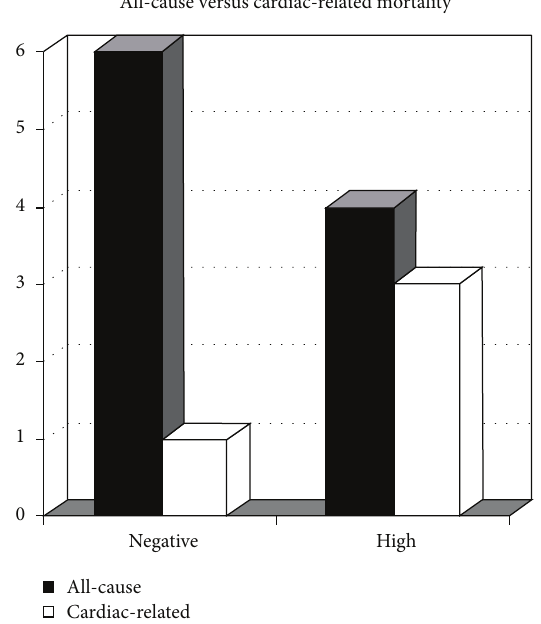
Figure 3: All-cause versus cardiac-related mortality in the negative versus high troponin groups. Note No deaths were observed in the intermediate troponin